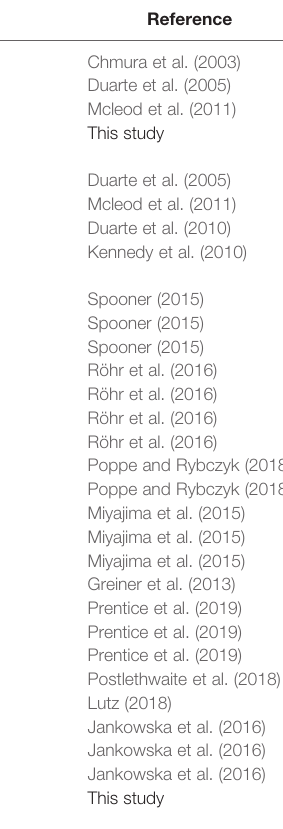
TABLE 7 | Global sediment OC (SOC) sequestration rates reported for salt marshes and seagrasses globally, and carbon sequestration rates reported for Z. marina in the Northern Hemisphere.